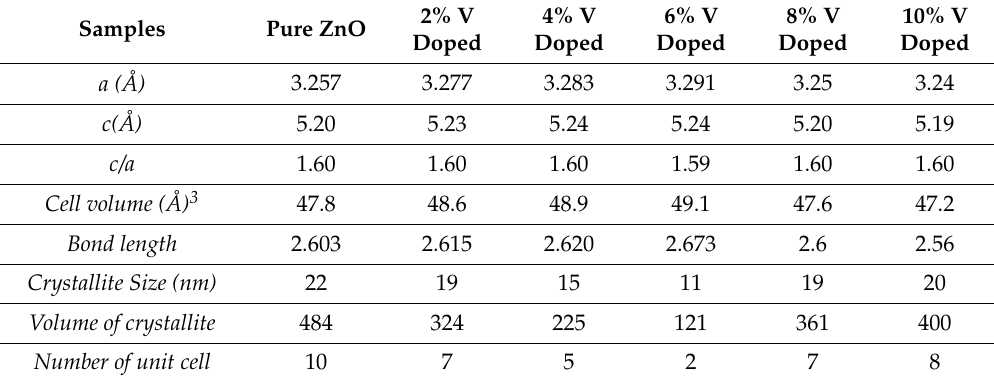
Figure 1. X-ray diffraction spectrum of V-doped ZnO nanoparticles (with x = 0.0, 0.02, 0.04, 0.06, 0.08, and 0.10). Table 1. XRD parameters for pure and 2–10% vanadium-doped ZnO nanocrystalline